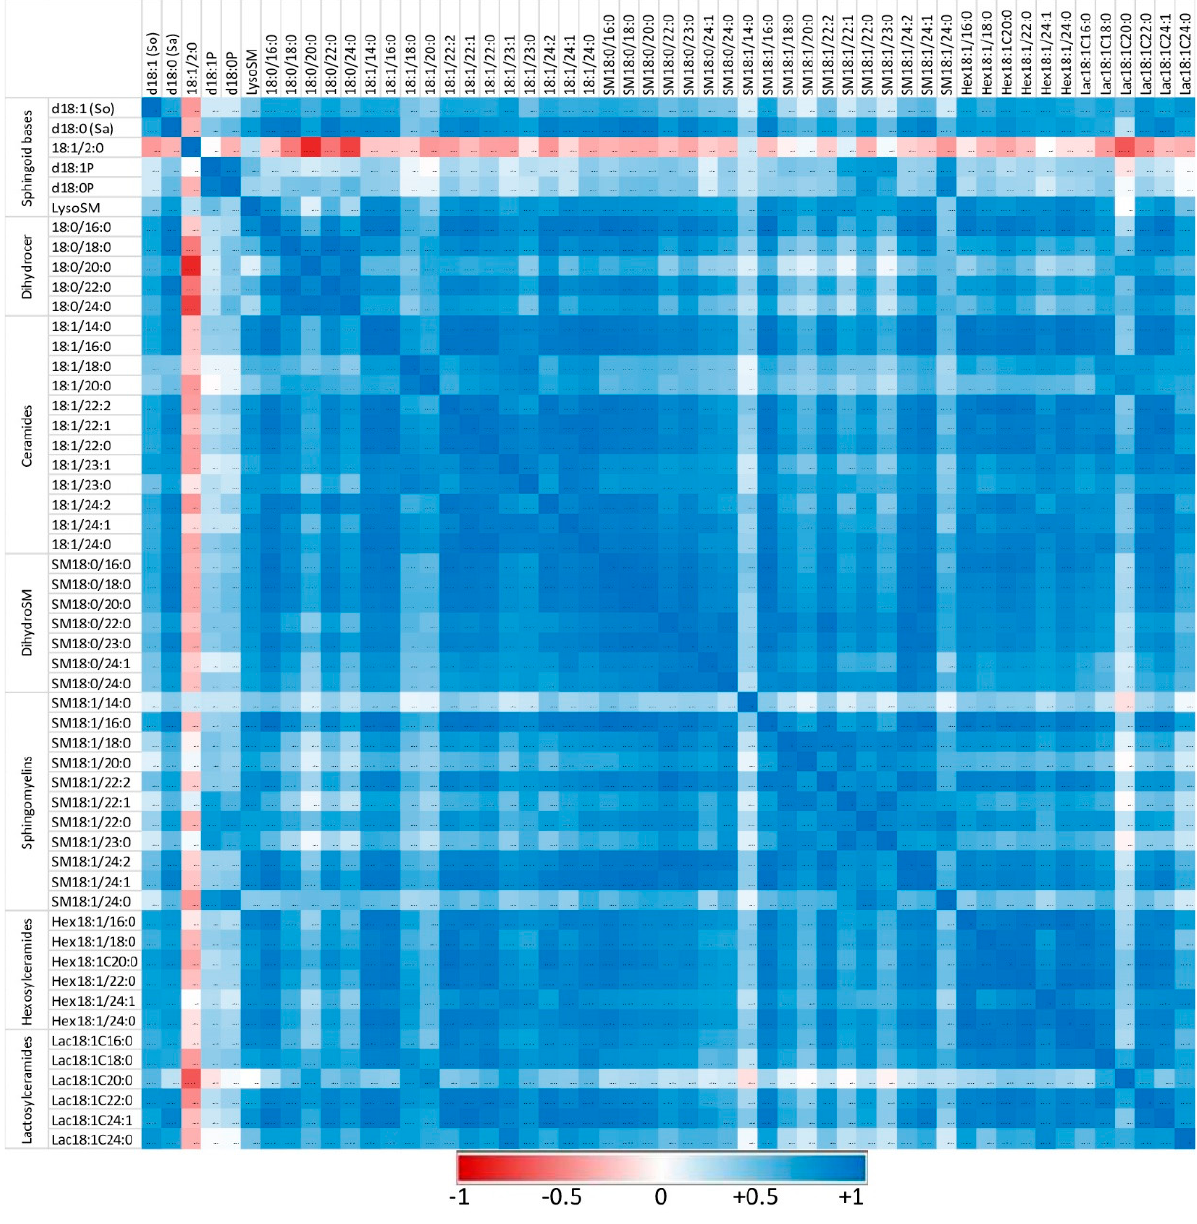
Figure 6. Correlation heatmap of sphingoid bases and sphingolipids with 14 to 24 carbon fatty acid chain lengths detected in the peritoneal cells of mice that received zymosan at a dose of 0.1 mg/mouse by the intraperitoneal route. Correlations are presented by sphingolipid class and by increasing size. The values of the Pearson coefficients of correlations observed among all sphingolipids assayed in this study are reported in Table S6. Blue represents a positive correlation, red represents a negative correlation, and white represents no correlation.